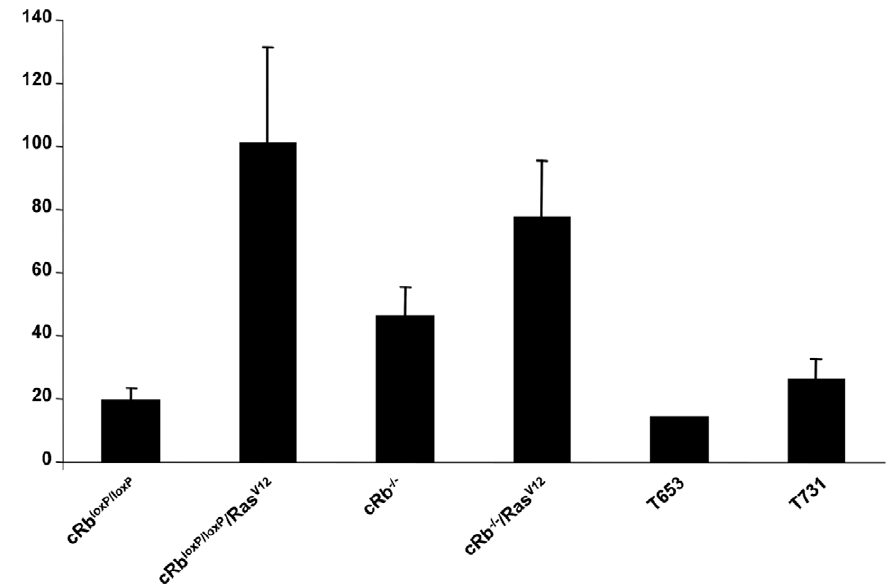
Figure 3. Quantification of cytochrome c oxidase activity. Comparison of respiratory activity between primary astrocytes (cRb loxP/loxP , cRb 2 / 2 , Rb loxP/loxP /Ras V12 and cRb 2 / 2 /Ras V12 ) and tumor cell lines revealed greater mitochondrial activity in astrocytes Rb loxP/loxP /Ras V12 and cRb 2 / 2 /Ras V12 than in the other cell groups, including cell lines T653 and T731.